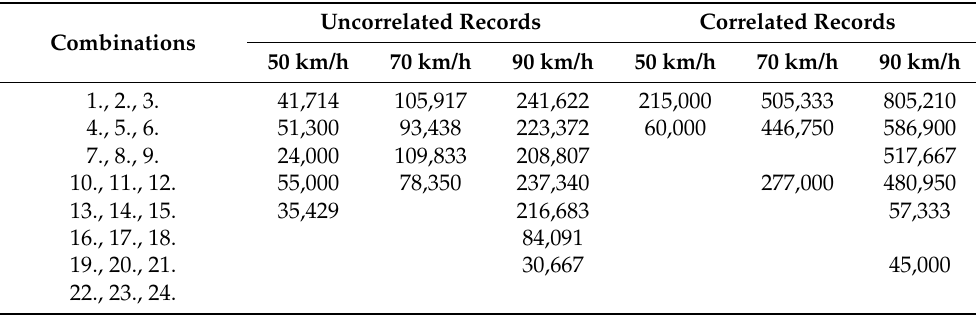
Table 10. Intercomparison of the average society-wide loss due to defect—Incorrect beginning/end of the crash barrier.